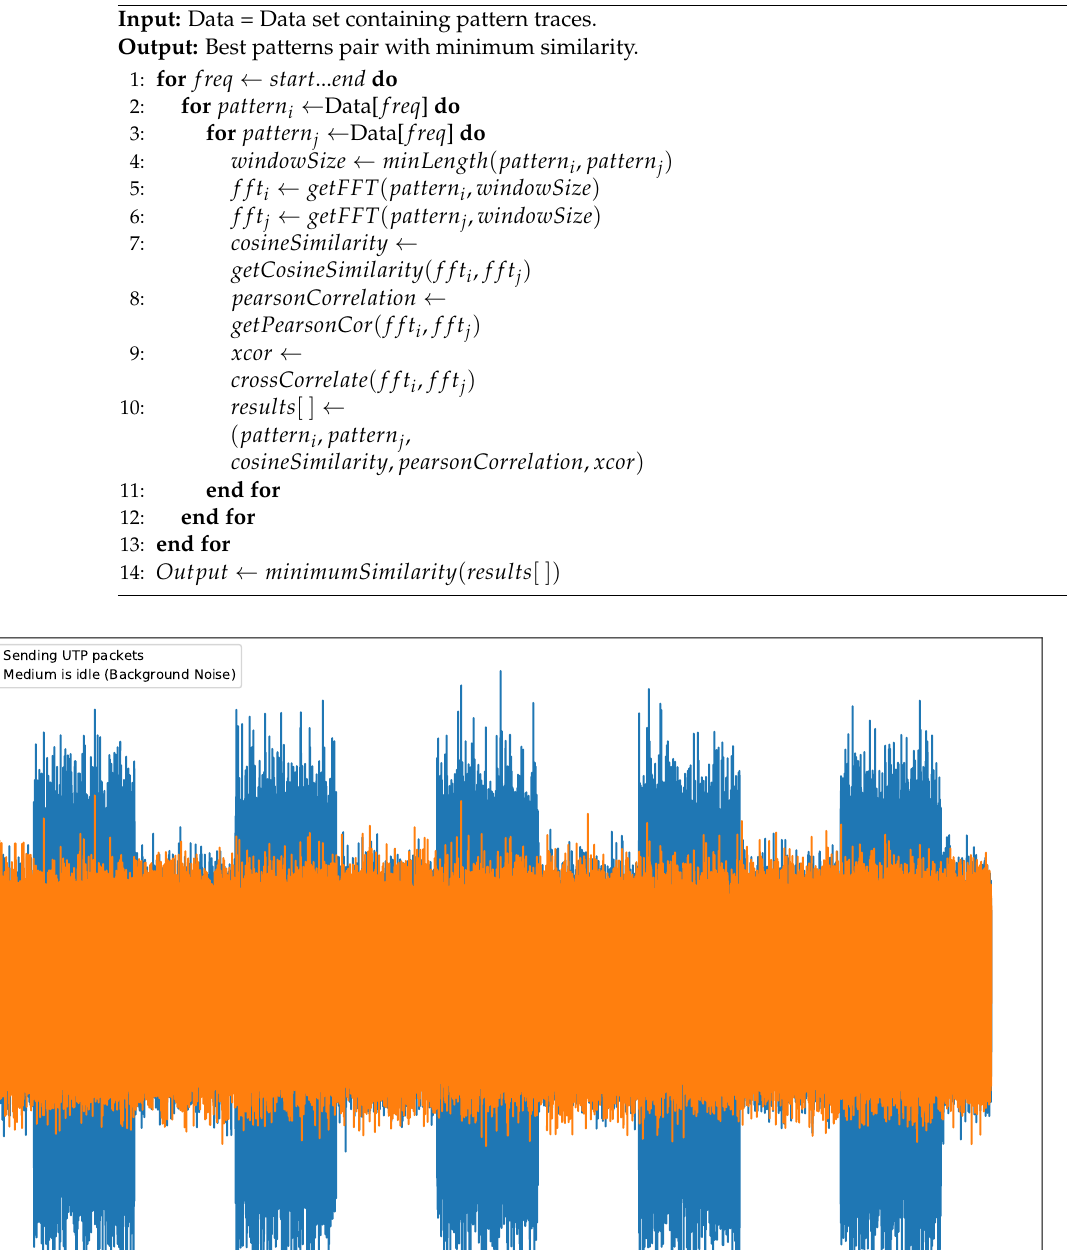
Algorithm 1 Leakage frequency analysis algorithm